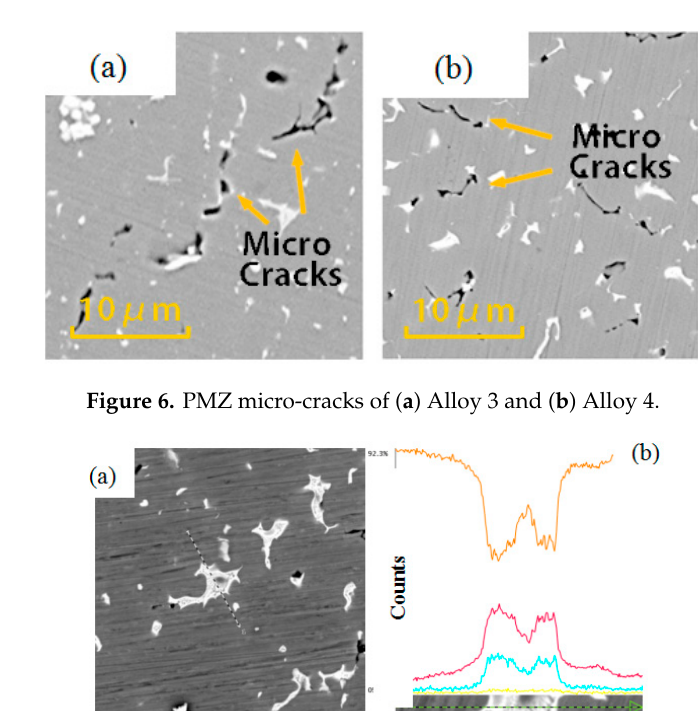
Figure 5. Scanning electron microscope (SEM) images of the PMZ in the welds: ( a ) Alloy 1, ( b ) Alloy 2, ( c ) Alloy 3, ( d ) Alloy 4, and ( e ) Alloy 5.